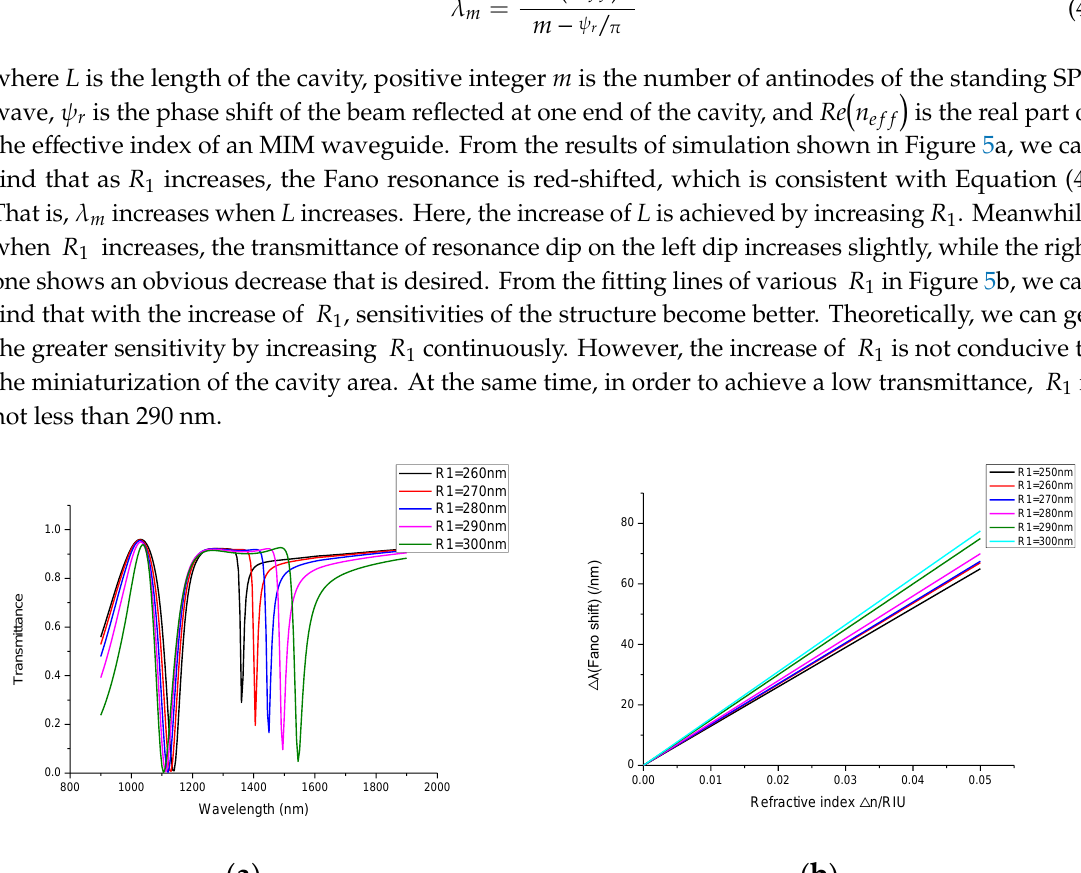
; ( b ) fitting line of the 185 1 . 186 1